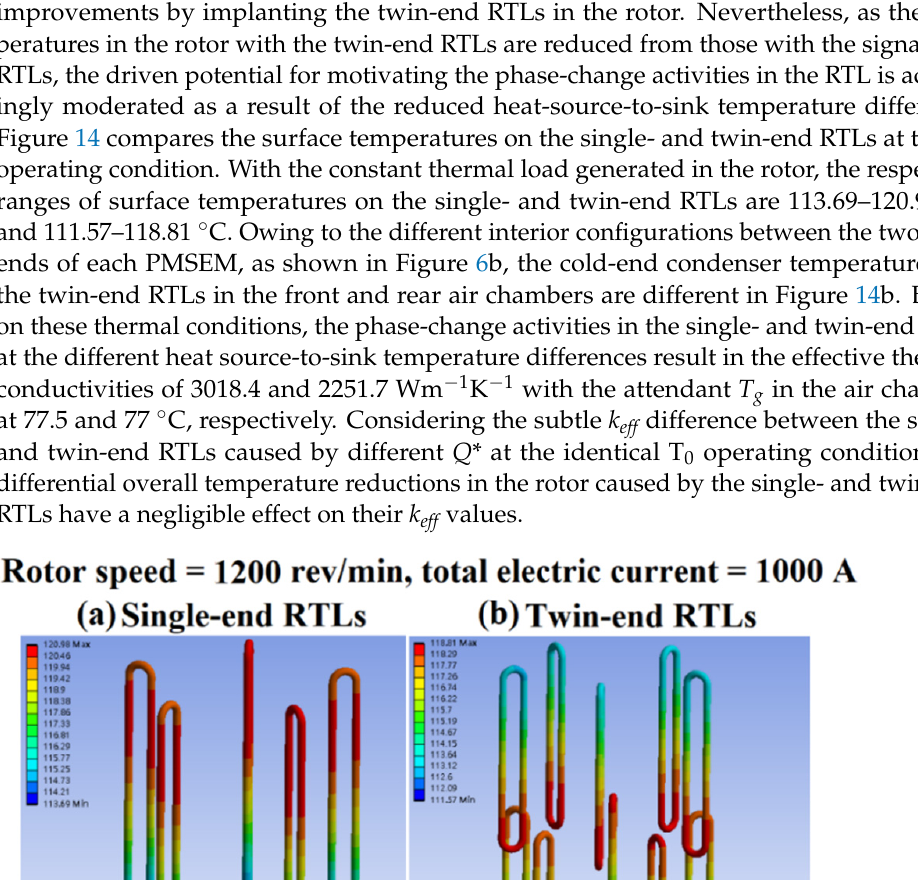
Figure 13. Detailed temperature distributions of the coiled windings in the PMSEM ( a ) without RTL and with ( b ) single-end RTLs and ( c ) twin-end RTLs at rotor speed of 1200 rev/min and total electric current of 1000 A.